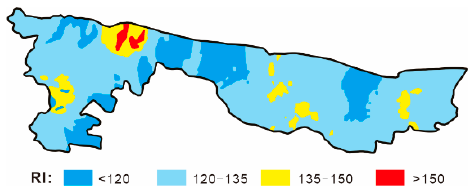
Figure 7. Spatial distribution of RI value in the investigated area.